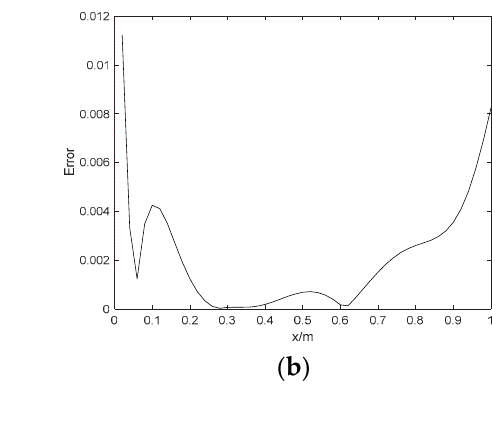
Table 1. The beam parameters.